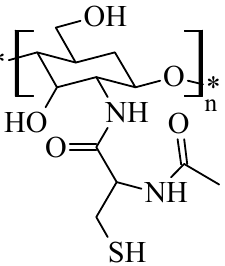
Figure 4. Structure of the chitosan- N -acetylcysteine derivative.